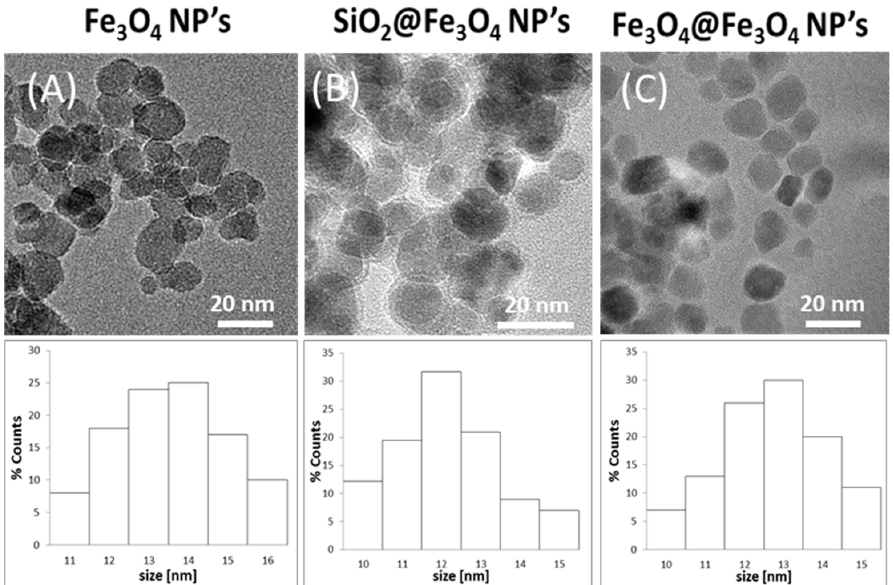
Figure 1. TEM images of magnetite nanoparticles from ( A ) iron chlorides; ( B ) with a silica shell; ( C ) from iron acetylacetonate and respective histograms for every type of tested nanoparticles. The presented TEM images indicate that the nanoparticles that have been selected for tests have a very similar shape and size, which was estimated to be 13 ± 2 nm for Fe 3 O 4 ; 12 ± 1 nm for SiO 2 @Fe 3 O 4 ; and around 12 ± 2 nm for Fe 3 O 4 @Fe 3 O 4 . The mean size of the nanoparticles is in good agreement with the data presented in the respective histograms.